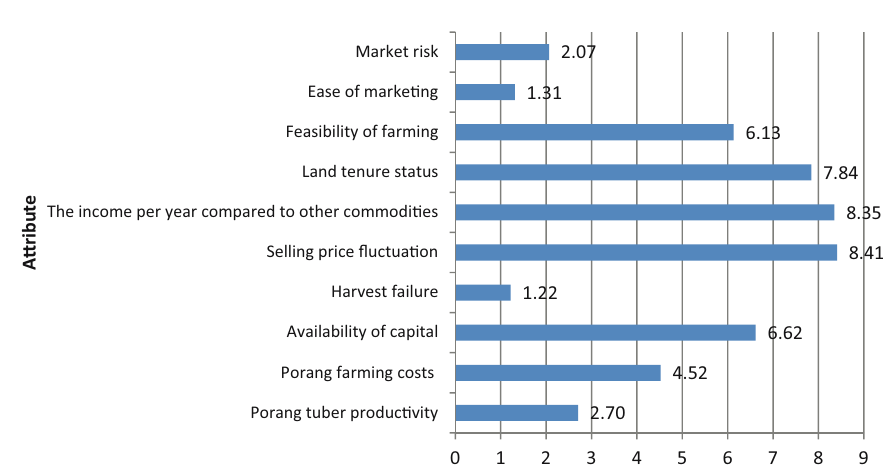
Figure 4: Economic